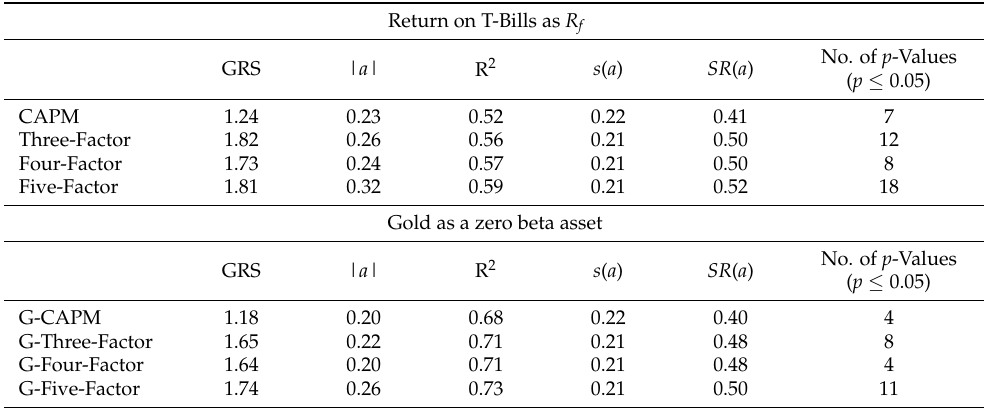
Table 6. Statistical summary of the GRS test in explaining monthly excess returns over Treasury bills and gold return with 49 industry portfolios from January 1981 to December 2015. Results represent monthly percent returns. The regressions use the CAPM, three-factor, four-factor, and five-factor models to explain excess returns on industry portfolios. The GRS statistic tests the null hypothesis that the alphas of all 49 portfolios are jointly equal to zero. | a | is the average absolute alpha for a set of time-series regressions of the 49 portfolios; R 2 is the mean-adjusted R-squared; s ( a ) is the mean standard error of the alphas; and SR ( a ) is the average Sharpe ratio of the alphas. The critical values for the GRS statistic are 90%: 1.41; 95%: 1.56; 97.5%: 1.69; 99%: 1.86, and 99.9%: 2.25. Return on T-Bills as R f No. of p -Values GRS | a | ( p ≤